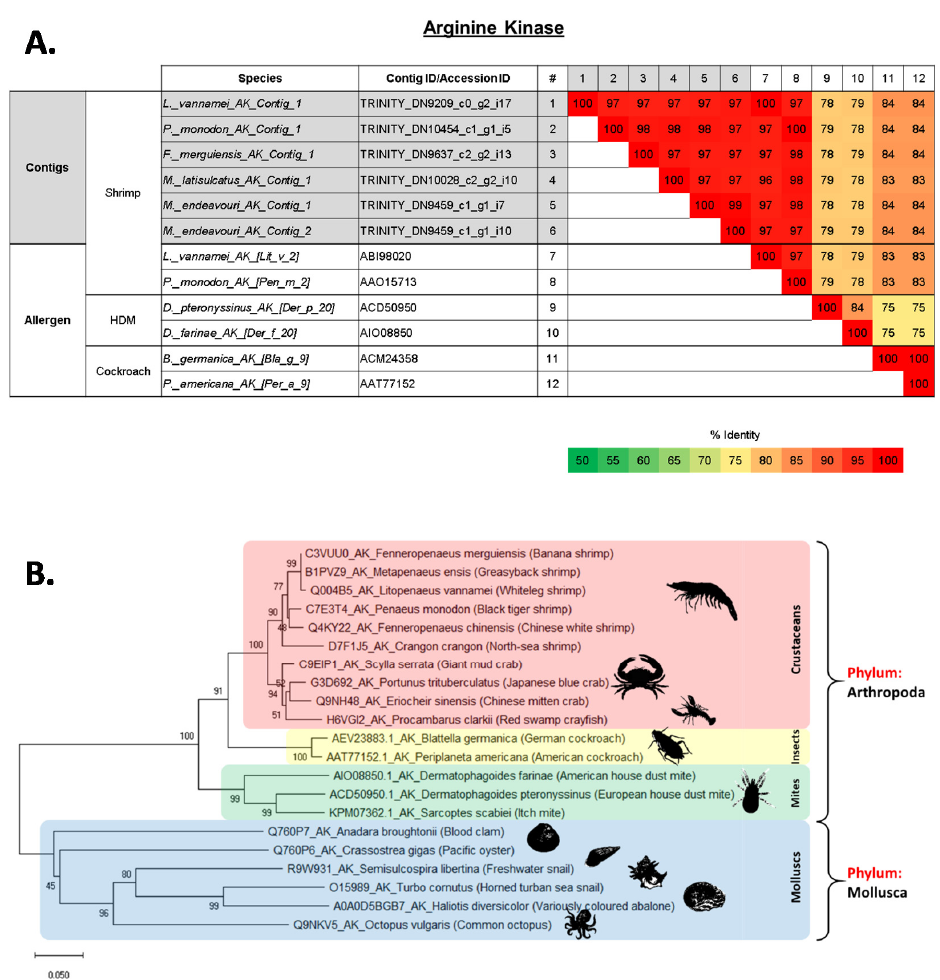
Figure 4. ( A ) Comparison of amino acid sequence identities of (1–6) contigs from five shrimp species that matched with arginine kinase (AK) allergens, (7–8) known shrimp AK allergens and (9–12) house dust mite and cockroach AK allergens. The sequence identities were calculated using multiple sequence alignment in Clustal Omega (EMBL-EBI). ( B ) Molecular phylogenetic tree based on published amino acid sequences of Arginine kinase (AK) from edible crustacean and mollusc species, and allergy causing mite and insect species. The branches consist of UniProt ID/Genbank Accession ID, species name, followed by common name in brackets. The numbers next to the branches indicate the bootstrap test percentage of 10,000 replicate trees.